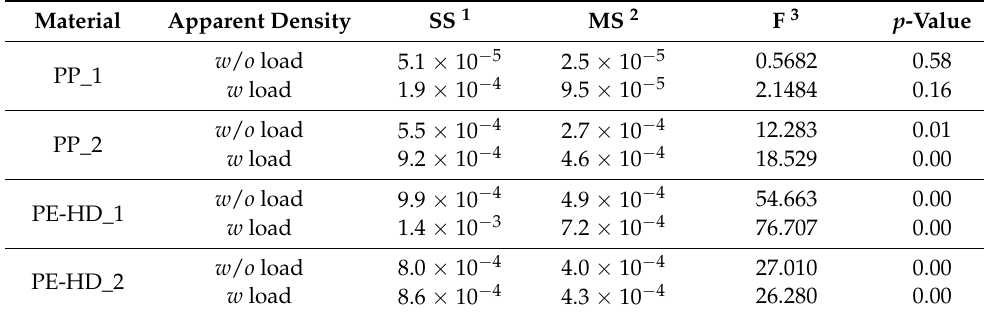
1 SS: sum of squares, 2 MS: mean square, 3 F: F